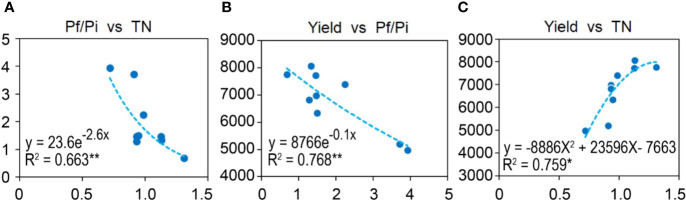
Correlations between (A) Pf/Pi and TN, (B) Yield and Pf/Pi, or (C) Yield and TN. Curvilinear of soil and wheat yield in the 2nd year. * represents the p < 0.05, ** represents the p < 0.01.